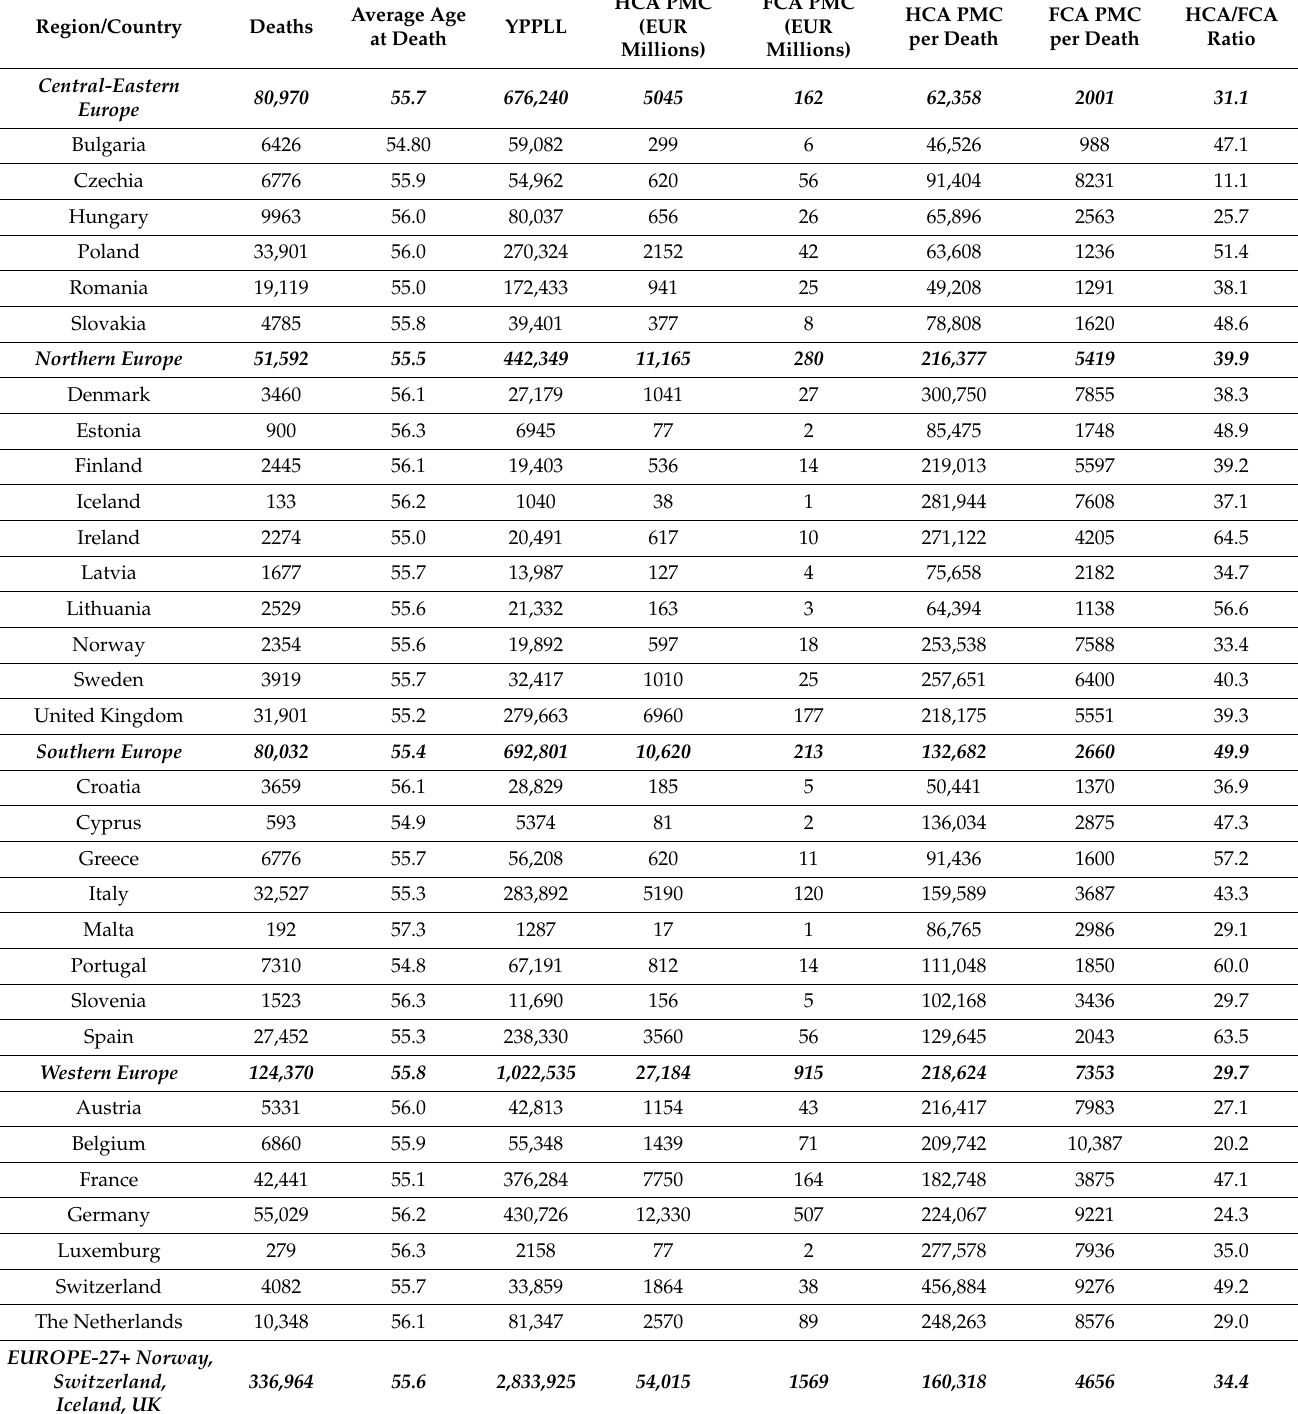
Table 1. Number of premature deaths due to cancer * (15–65 years), age of death, Years of Potential Productive Life Lost (YPPLL), cancer-related premature mortality costs (PMC) (EUR, total and per death) by Human Capital Approach (HCA) and Friction Cost Approach (FCA) and HCA/FCA ratios for Europe by region and country in